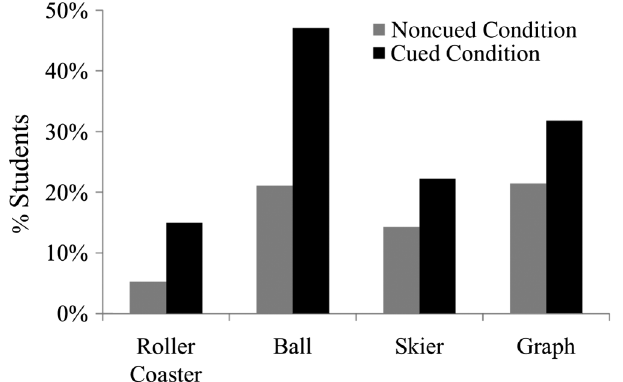
AOI.FIG. 8. Comparison of percentage of participants in cued and noncued conditions who gave the correct answer and reasoning on the transfer problem for each problem set in the study. For example, 15% ¼ 3 = 20 students in the cued condition answering correctly on the roller coaster transfer